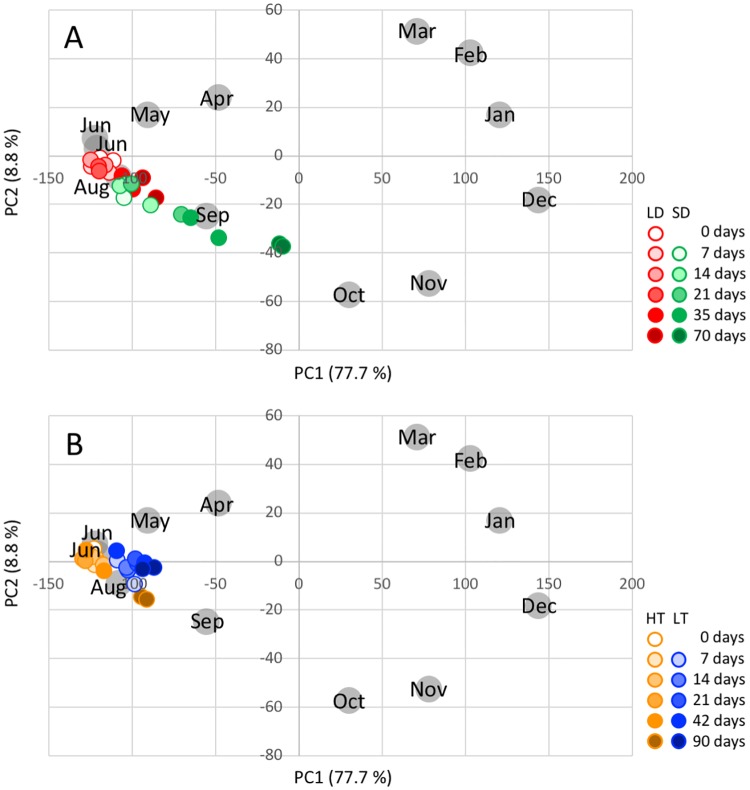
PCA of microarray data.The first two principal components obtained from PCA of annual time series samples of microarray data are shown (gray circles). The seasonal conditions of Japanese cedar grown in a controlled-environment chamber were estimated by plotting microarray data against the PCA results of annual time series samples. (A) Red and green circles indicate samples collected from cuttings grown under LD and SD conditions, respectively. (B) Orange and blue circles indicate samples collected from cuttings grown under HT and LT conditions, respectively.